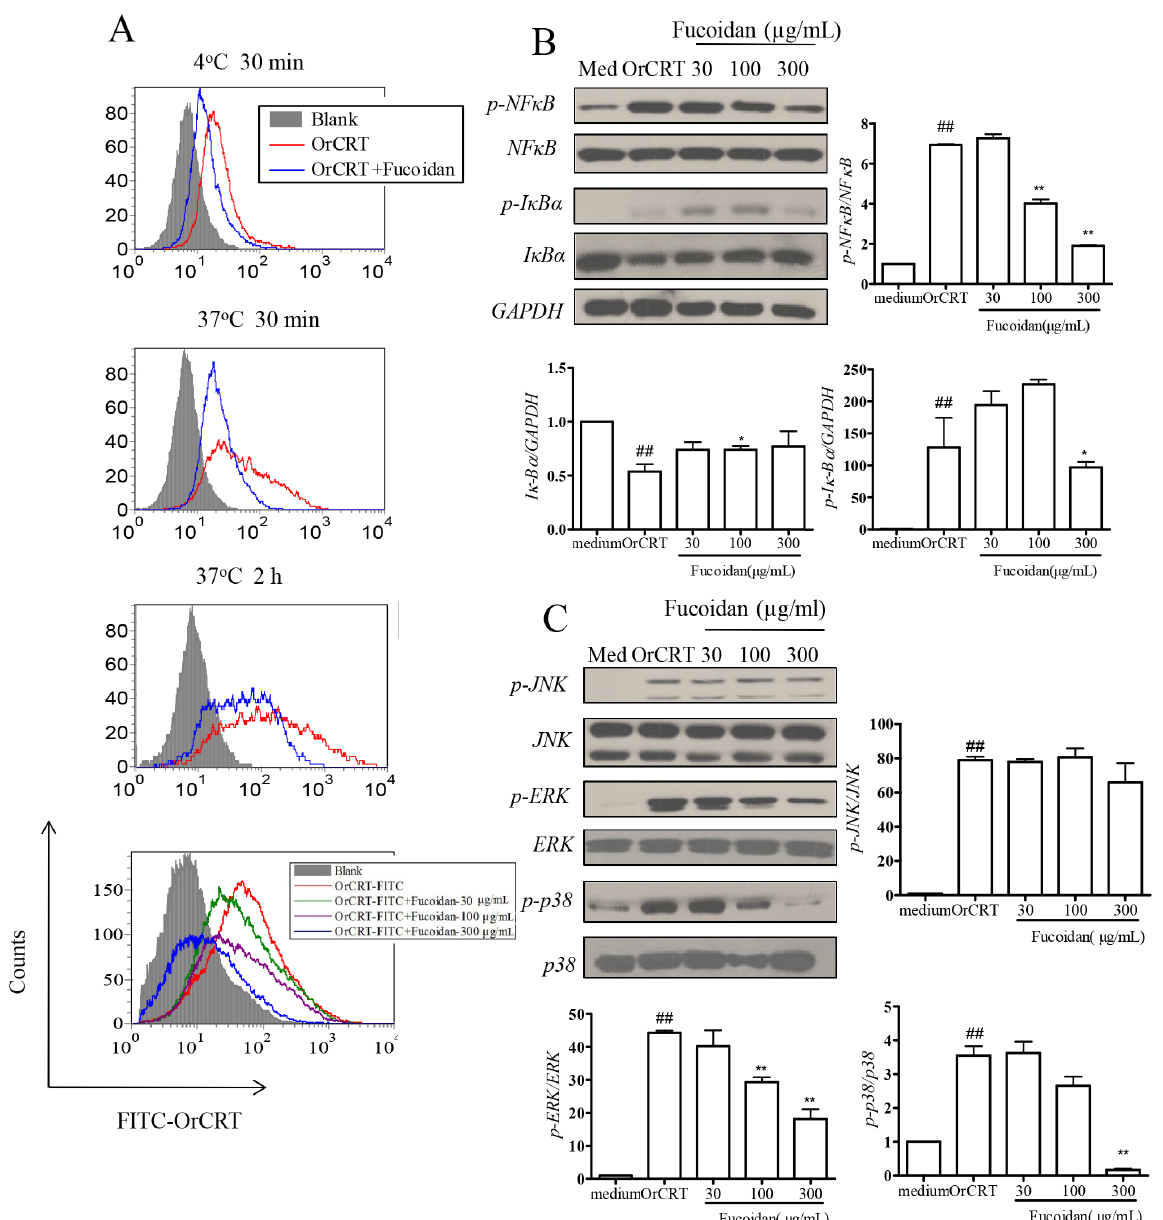
Figure 5. Scavenger receptor A (SRA) is involved in rCRT internalization by macrophages. ( A ) Freshly isolated mouse peritoneal macrophages were pre-incubated with fucoidan (100 μ g/mL) for 2 h at 37 °C. Then FITC-OrCRT (10 μ g/mL) was added and the cells were incubated further at 4 °C for 30 min, or at 37 °C for 30 min or 2 h, before flow cytometric analysis. Cells pre-treated with various concentrations of fucoidan (shown in the figure) followed by FITC-OrCRT for 30 min at 37 °C were also analyzed as control (bottom left panel). For function assay, peritoneal macrophages were pre-incubated with various concentrations of fucoidan at 37 °C for 2 h, followed by stimulation with OrCRTs (10 μ g/mL) for 30 min. Cell lysates were analyzed by SDS-PAGE and immunoblotted for NF κ B ( B ) and MAPK ( C ) pathway related proteins. Semi-quantitative densitometric analysis results of the Western blots are also shown. ## p < 0.01 OrCRT group vs . Medium group; * p < 0.05, ** p < 0.01 vs OrCRT